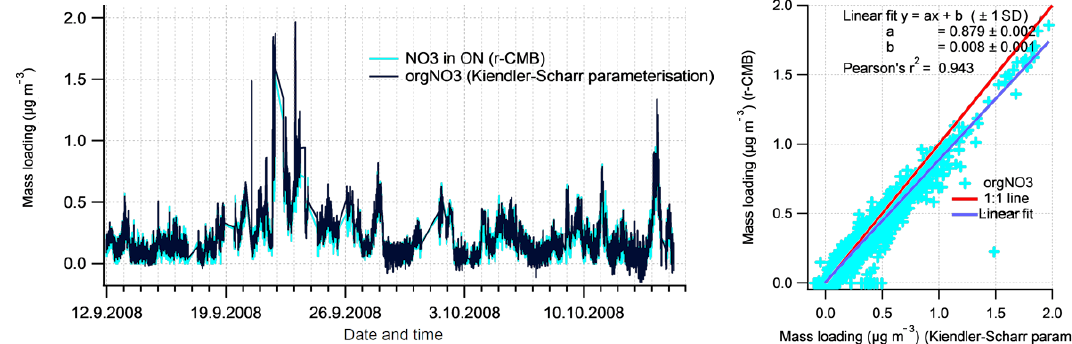
Figure 11. Comparison of Kiendler-Scharr parameterisation (Kiendler-Scharr et al., 2016; black line; moving median filter for 11 points = 0 . 1) for organonitrate with NO window applied; R calib = 0 . 42, R orgNO 3 ion species in ON factor from our r-CMB model (in 3